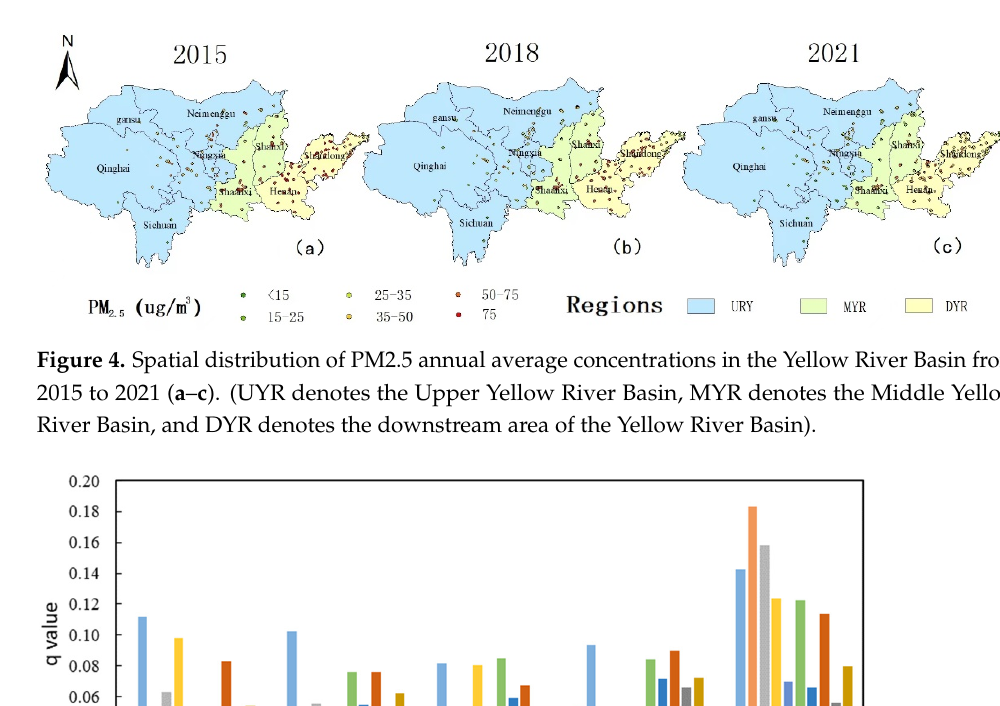
2015 to 2021 ( a – c ). (UYR denotes the Upper Yellow River Basin, MYR denotes the Middle Yellow River Basin, and DYR denotes the downstream area of the Yellow River Basin.)